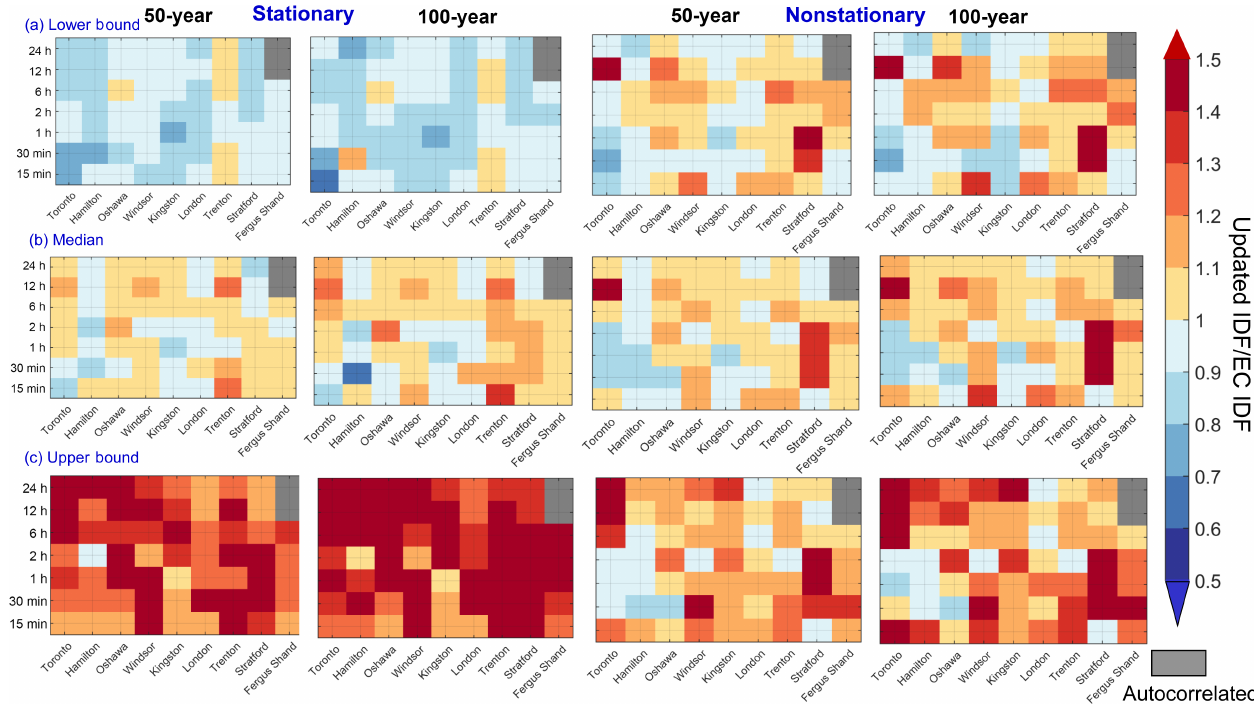
Figure 7. Central tendency (median, b ) and the bounds (95% credible interval, a and c ) of the updated nonstationary vs. EC-generated T = 50- and 100-year event estimates for DSI at selected return periods with durations between 15min and 24h. The DSI and associated 95% confidence limits of EC-generated IDFs are obtained from the national archive of Engineering Climate Datasets (http://climate.weather. gc.ca/). The shades in blue and red denote decrease and increase in DSI. The strength of shading represents the magnitude of the ratio between updated and EC-generated DSI.